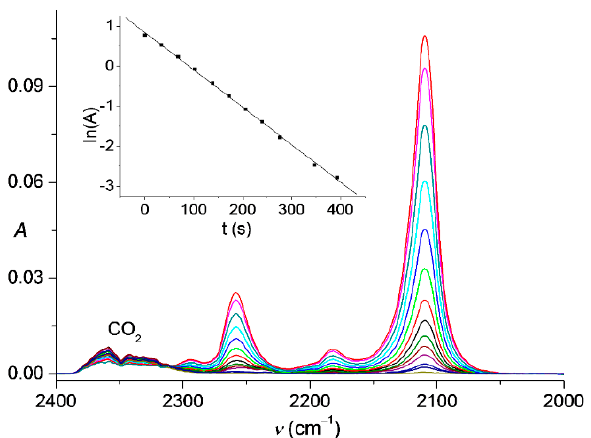
Figure 2 . IR spectra of gaseous Me 3 SiCCN 3 ( 6 ) in the range of 2400–2000 cm − 1 showing its thermal decay at 282 K in 680 s. Inset: First-order kinetics for the decomposition, the corresponding rate constant is (9.36 ± 0.11) × 10 − 3 s − 1 and half-life time is 74 s.